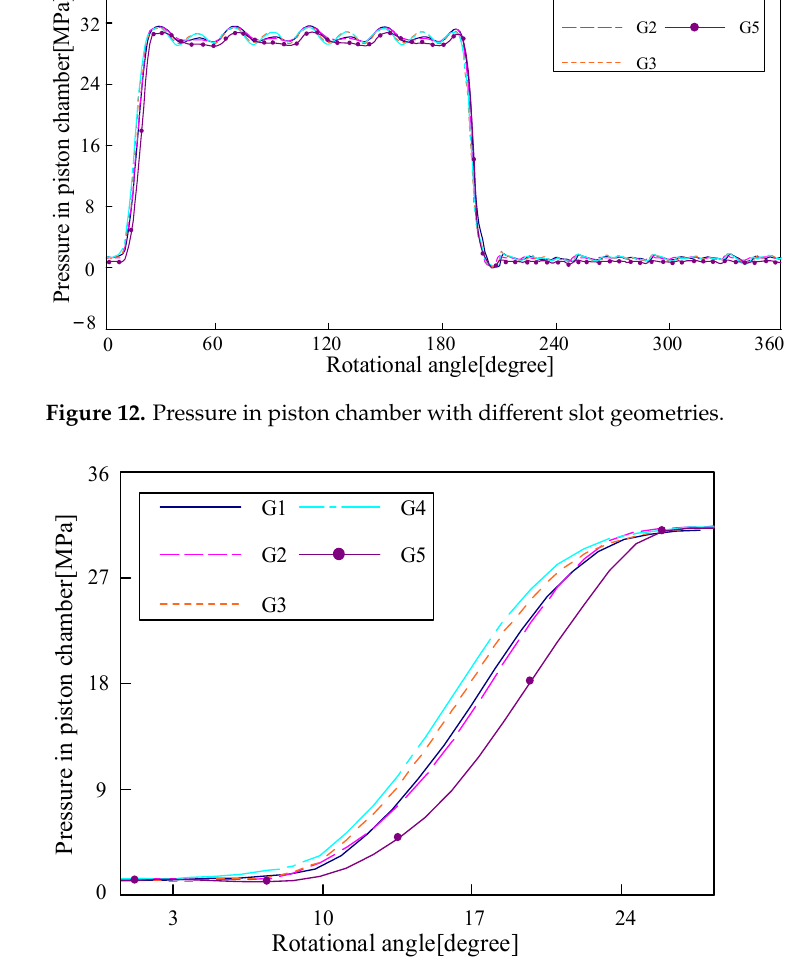
Figure 12. Pressure in piston chamber with different slot geometries.